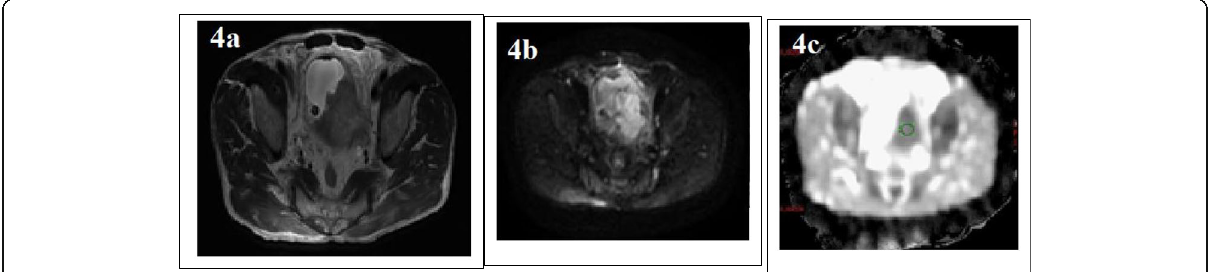
Fig. 4 Transitional cell carcinoma, stage T4 and grade 3, matching with T2WI ( a ) and DWI ( b ). The mean ADC = 1.32 × 10 − 3 mm 2